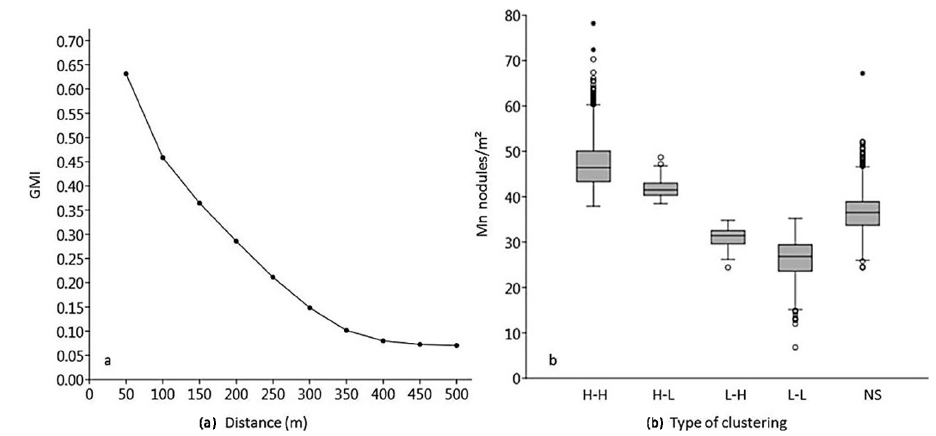
Figure 4. (a) The GMI decrement due to increasing distance, after the first 50m. (b) The range of Mn nodules m − 2 in each clustered